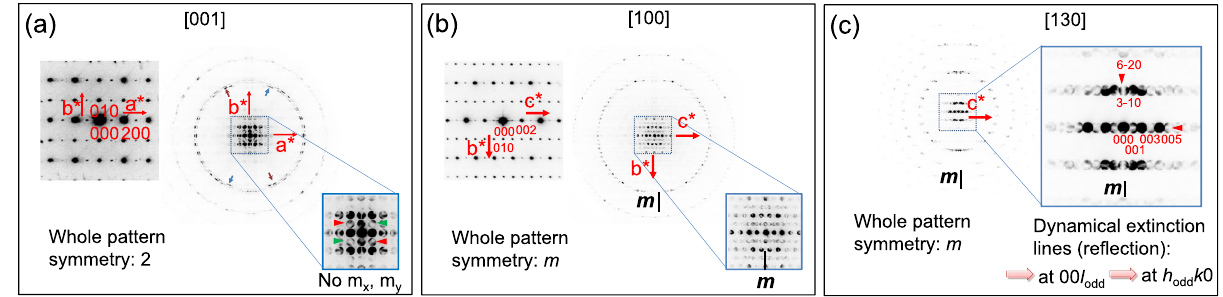
Fig. 3 The converge beam electron diffraction (CBED) patterns at room temperature in NaRu 2 O 4 crystal. The CBED patterns are taken with ( a ) [001], ( b ) [100], and ( c ) [130] incidences. Whole pattern symmetries of the CBED patterns are two-fold symmetry for [001] incidence, mirror symmetry perpendicular to the c-axis for [100] and [130] incidences. Dynamical extinction lines were observed at 0 0 l odd and h odd k 0 re fl ections at [130] incidence.